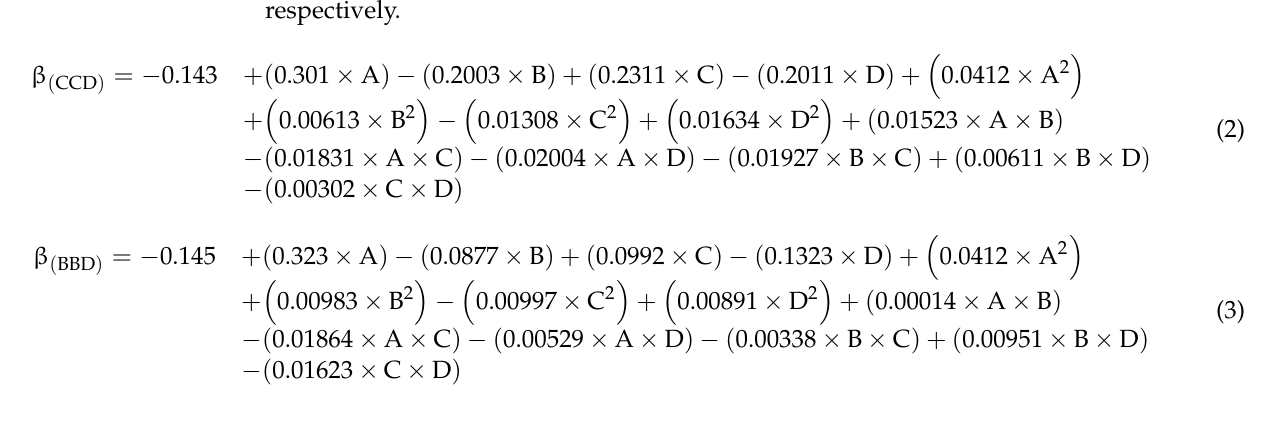
Table 2. Experimental parameters and their